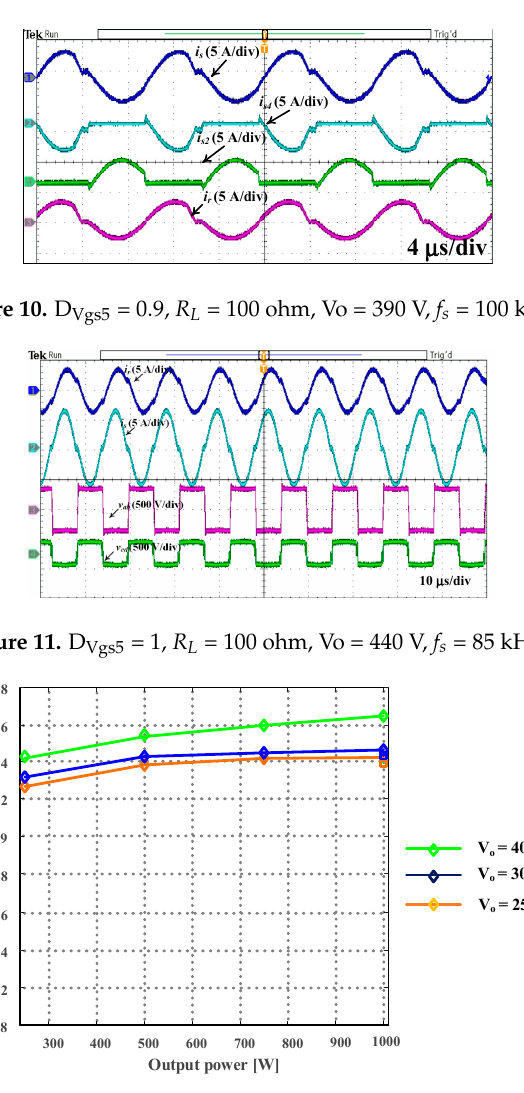
Figure 12. Experimental Efficiency.